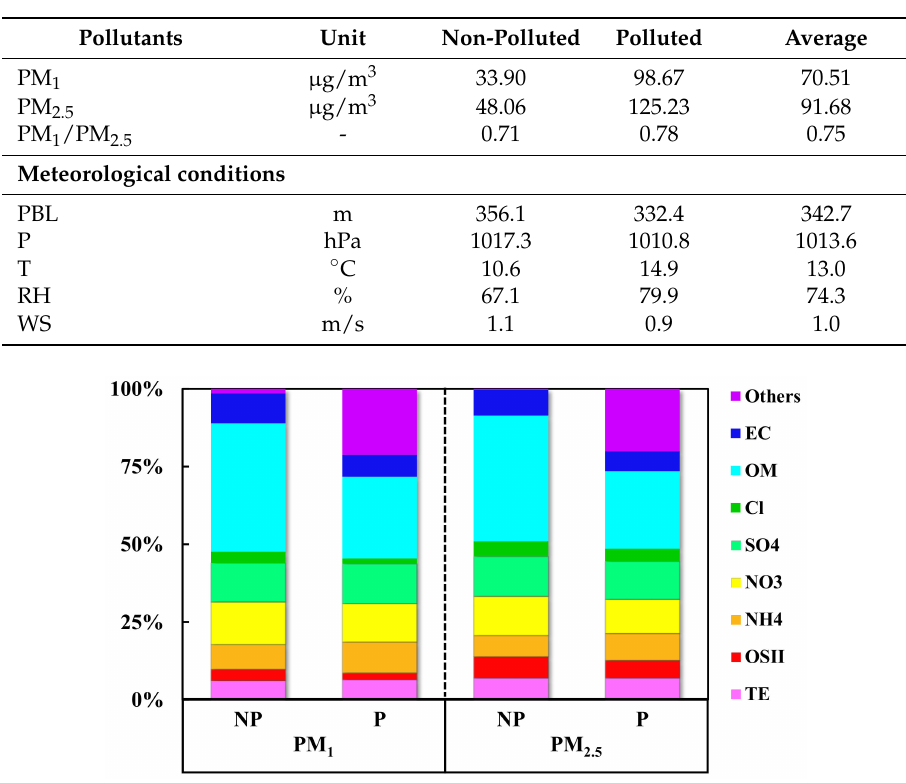
Table 3. Air quality and meteorological conditions during non-polluted and polluted situations.